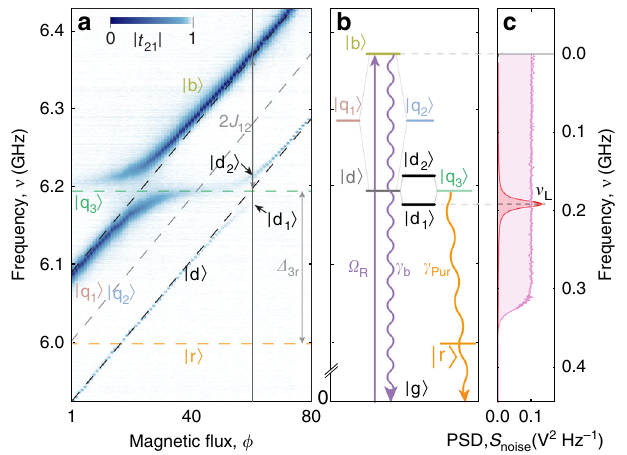
Fig. 2 Measured spectrum, energy levels, and applied environmental noise spectra. a Transmission spectra ∣ t 21 ( ω ) ∣ of the three-qubit system measured through the transmission line as a function of magnetic fl ux. Here and in the following, spectral features are labeled by the target state (|q 1 〉 , |q 2 〉 , |q 3 〉 , |b 〉 , |d 〉 , |d 1 〉 , |d 2 〉 , |r 〉 ) reached in spectroscopic experiments from the ground state |g 〉 of the system. b Energy-level diagram at the magnetic fl ux indicated by a gray vertical line in a . The resonant states |q 1 〉 and |q 2 〉 form bright |b 〉 and dark |d 〉 states. Furthermore, |q 3 〉 is resonant with the |d 〉 state forming |d 1 〉 and |d 2 〉 doublet. Solid downward arrows indicate decay channels; the upward arrow indicates excitation via the waveguide. c Measured power spectral density (PSD) S noise of the environmental low frequency noise applied to the fl ux line of Q 2 . White noise with 325 MHz cutoff is depicted in pink and Lorentzian noise with central frequency ν L in